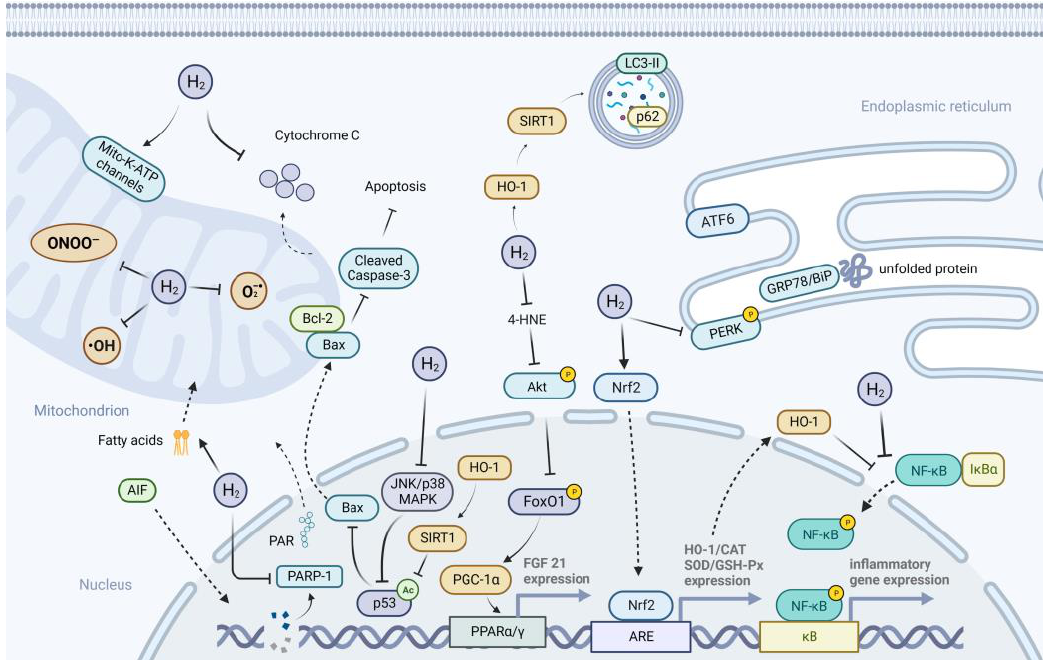
Figure 3. The possible mechanisms underlying the effects of H 2 on metabolic diseases. The figure demonstrates the potential mechanisms underlying the effects of H 2 on metabolic diseases, includ- ing scavenging or inhibiting generation of ROS; activating Mito-K-ATP channels; promoting the transport of fatty acids into mitochondria; as well as the pathways involved in the anti-oxidative, anti-inflammatory, and anti-apoptotic effects, and suppression of ER stress and activation of au- tophagy, including the Nrf2/ARE/HO-1, PARP-1/AIF, HO-1/SIRT1/p53, JNK/p38 MAPK/p53, Akt/FoxO1/PGC-1α/PPARα/γ, NF-kB-mediated, and PERK-mediated UPR pathways. Abbrevia- tions: Mito-K-ATP, mitochondrial ATP-sensitive potassium; SIRT1, Sirtuin1; LC3-II, microtubule- associated protein light chain 3-II; HO-1, heme oxygenase-1; ATF6, activating transcription factor 6; GRP78/BiP, glucose-regulated protein 78/binding immunoglobulin protein; PERK, proteins R (PKR)-like endoplasmic reticulum kinase; 4-HNE, 4-hydoxy-2-nonenal; FoxO1, forkhead box O1; PGC-1α, peroxisome proliferator-activated receptor gamma coactivator-1 alpha; PPARα/γ, peroxi- some proliferator-activated receptor alpha/gamma; Nrf2, nuclear factor erythroid 2-related factor 2; ARE, antioxidant responsive element; NF-kB, nuclear factor-kappaB; IkBα, inhibitory subunit of NF-kB alpha; JNK/p38 MAPK, c-Jun N-terminal kinase/p38 mitogen-activated protein kinase; Bcl-2, B-cell lymphoma 2; Bax, Bcl-2-associated X protein; PARP-1, poly (ADP-ribose) polymerase-1; PAR, poly(ADP-ribose); AIF, apoptosis-inducing factor; CAT, catalase; SOD, superoxide dismutase; GSH-Px, glutathione peroxidase; FGF21, fibroblast growth factor 21.